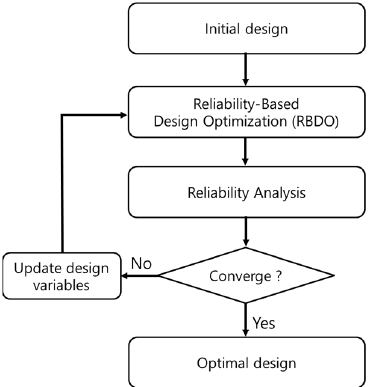
Figure 5. Flowchart of the reliability-based design optimization process.